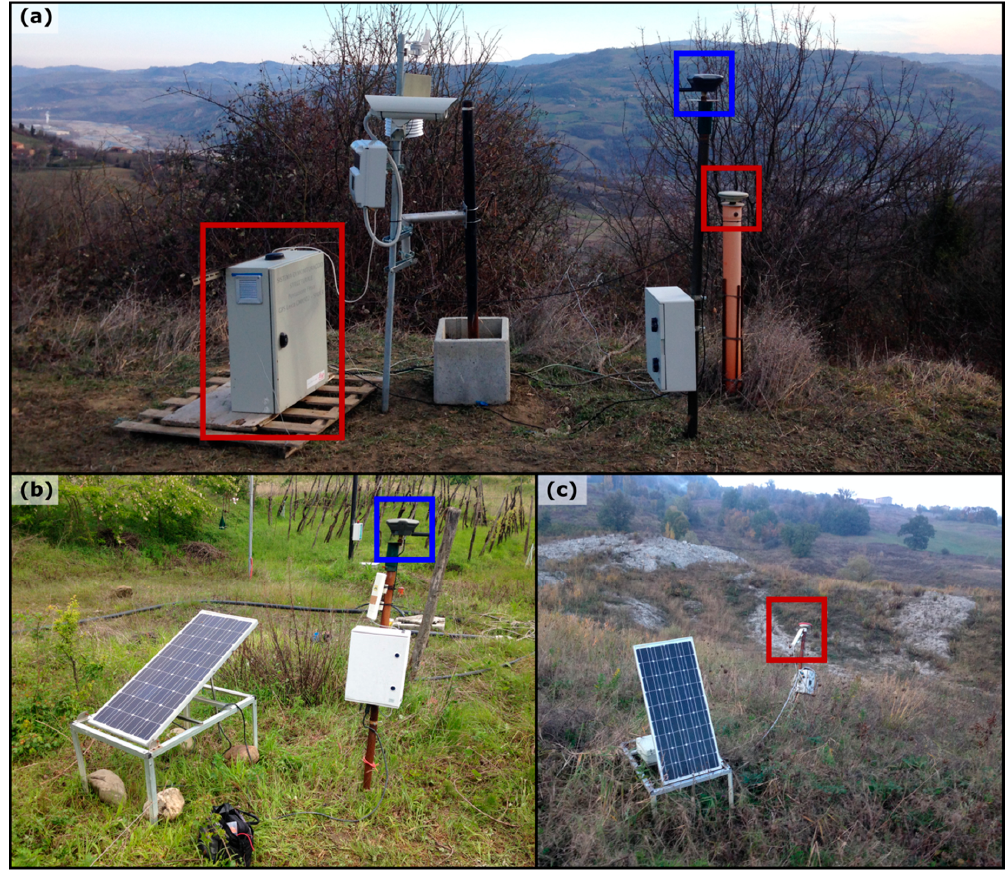
Figure 4. GNSS receivers installed at the Ca’ Lita landslide. ( a ) Reference stations. Within the red squares are the Leica post-processing unit (left) and the Leica double frequency receiver on the right (model GMX902). In the blue square is the Emlid single frequency low cost receiver (model Reach RS) acting as a reference station. ( b ) Reach RS receiver is installed as ROV3b rover unit and its photovoltaic power unit. ( c ) Leica GMX901 receiver is installed as ROV2b rover unit and its photovoltaic power unit. During period “a”, ROV1a, ROV2a and ROV3a were equipped with Leica GMX901 receivers. During period “b”, ROV1b and ROV2b were equipped with Leica GMX901 receivers, while ROV3b was equipped with the low-cost Emlid Reach RS.